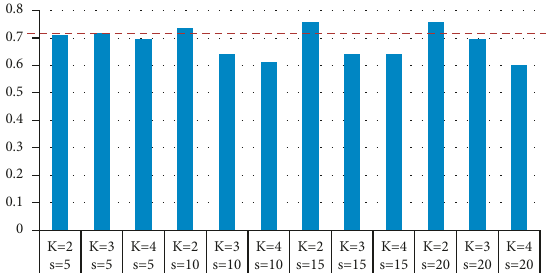
Figure 9: Specificity of CBCD on BAC with a threshold 0.01.